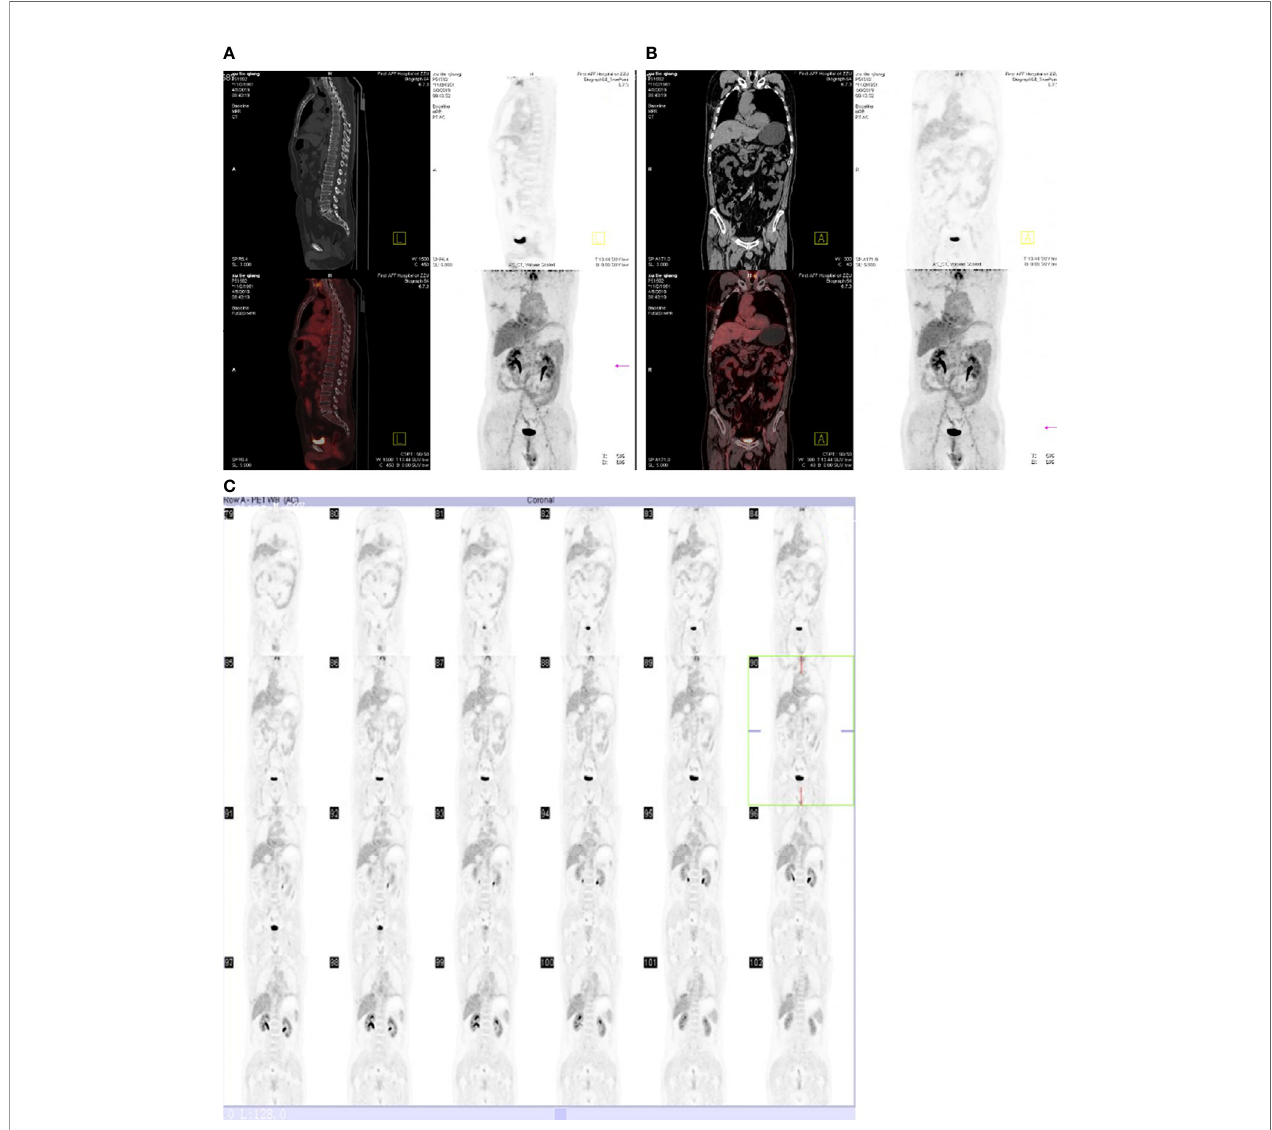
FIGURE 5 | Reexamination PET-CT scan showing CR after six cycles of second-line